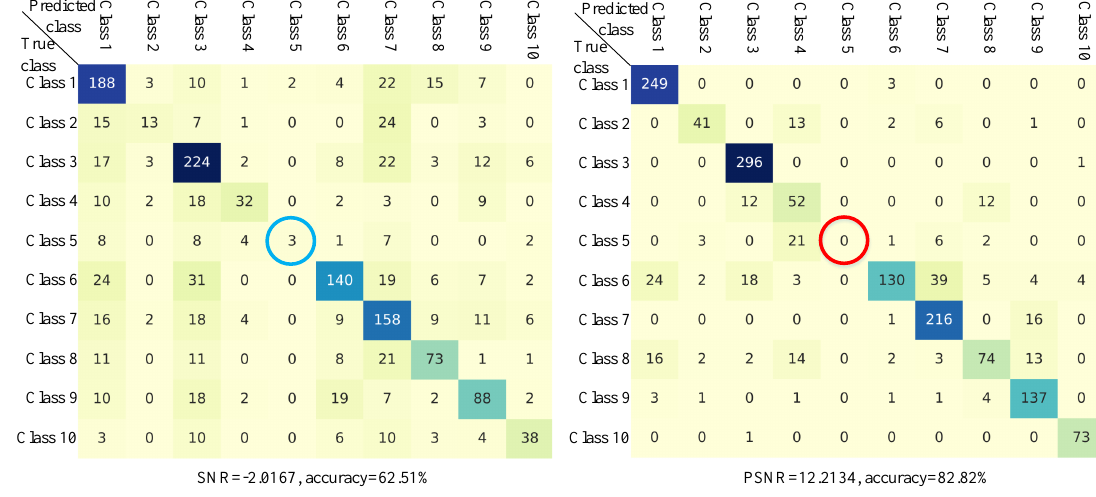
( b ) Confusion matrix of Visual.